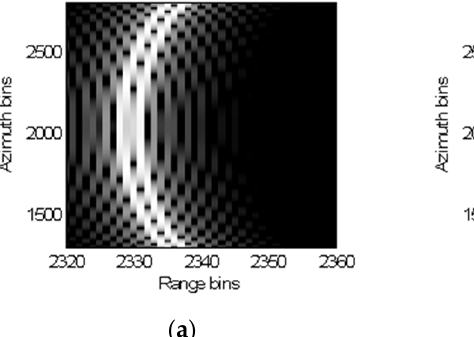
( d ) Figure 6. Point targets imaging results, ( a ) CSA with PGA applied; ( b ) CSA with proposed one- step MOCO method; ( c ) imaging method in [20]; ( d ): proposed imaging method. We then present the quantitative evaluation of the reconstruction results for various input SNRs, as shown in Figure 6. Since the method in [19] fails to reconstruct points 1